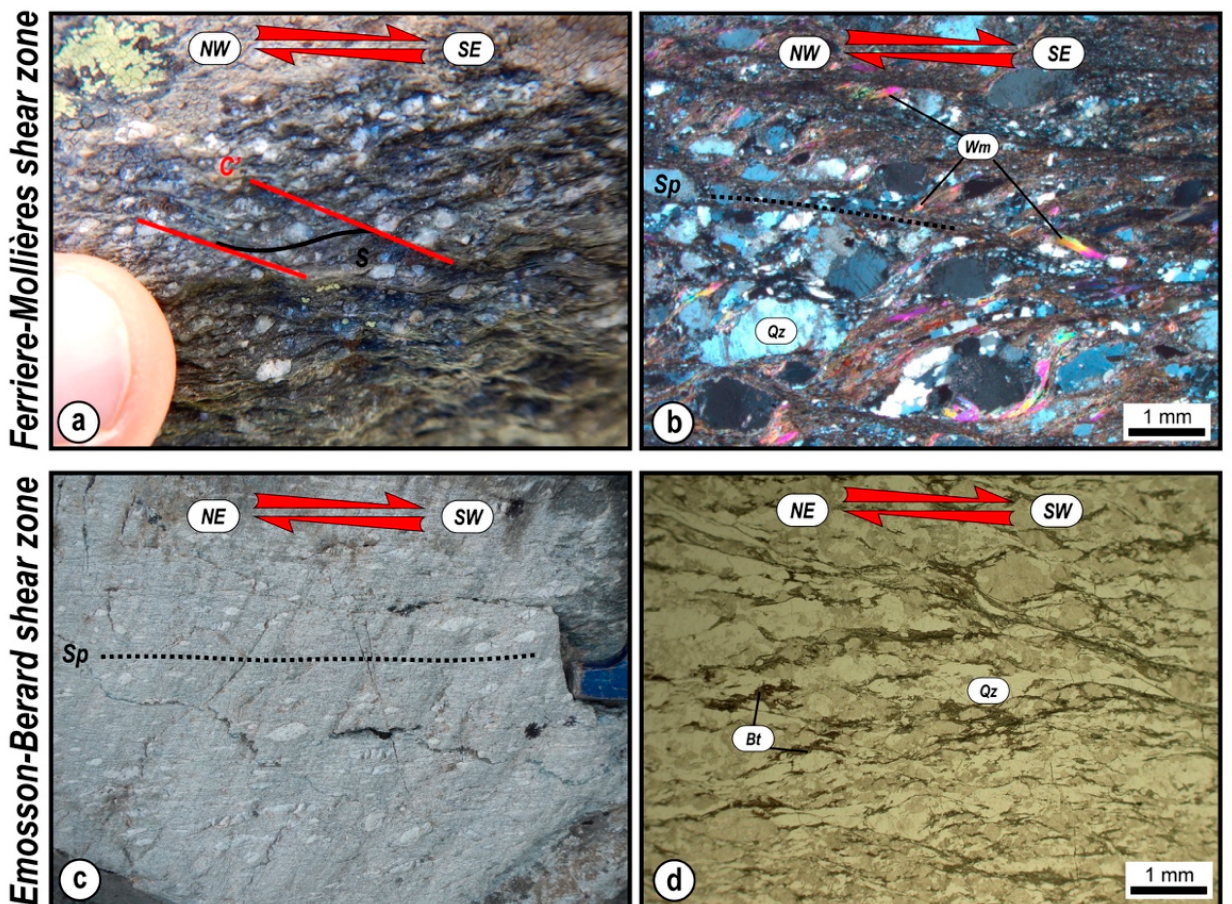
Figure 7. Evidence of shear deformation at the meso- and microscale of the FMSZ and of the EBSZ: ( a ) Mylonite at the outcrop-scale showing an S-C ′ fabric indicative of a top-to-the-SE sense of shear; Sp is the mylonitic foliation (coord. Lat 44°18 ′ 23.90 ″ N—Long. 6°59 ′ 38.40 ″ E); FMSZ. ( b ) S-C-C ′ fabric, mica fish and asymmetric porphyroclasts at the microscale showing a top-to-the-SE sense of shear (coord. Lat 44°18 ′ 23.90 ″ N—Long. 6°59 ′ 38.40 ″ E); FMSZ (CPL). ( c ) σ ‐ type K ‐ feldspar porphyroclast of centimetric size in sheared orthogneiss; Sp is the mylonitic foliation (coord. Lat 46°00 ′ 19.55 ″ N—Long. 6°51 ′ 56.15 ″ E); EBSZ. ( d ) Anastomosing disjunctive foliation in orthogneiss showing S-C ′ fabric pointing to a top-to-the-SW sense of shear in mylonite (coord. Lat 46°03 ′ 55.00 ″ N—Long. 6°55 ′ 30.00 ″ E); EBSZ (PPL).